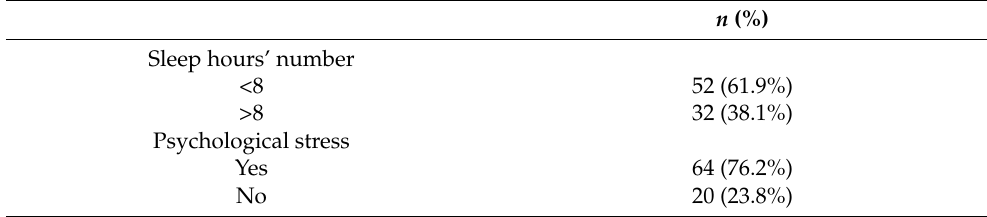
Table 5. Sleep hours and psychological stress after online distance learning.